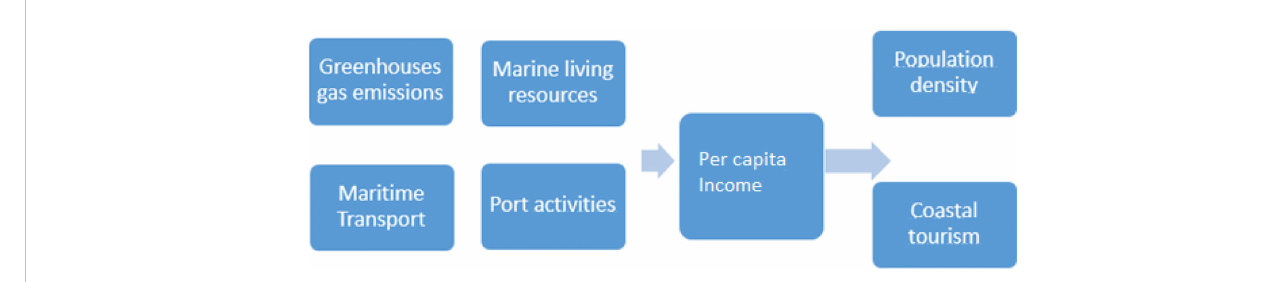
FIGURE 1 Causal relationship between variables with